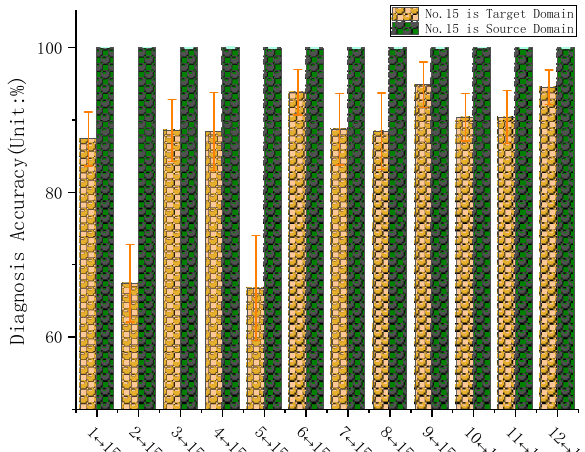
Figure 12. The results between variable speed condition No. 15 and the other 12 constant speed conditions.